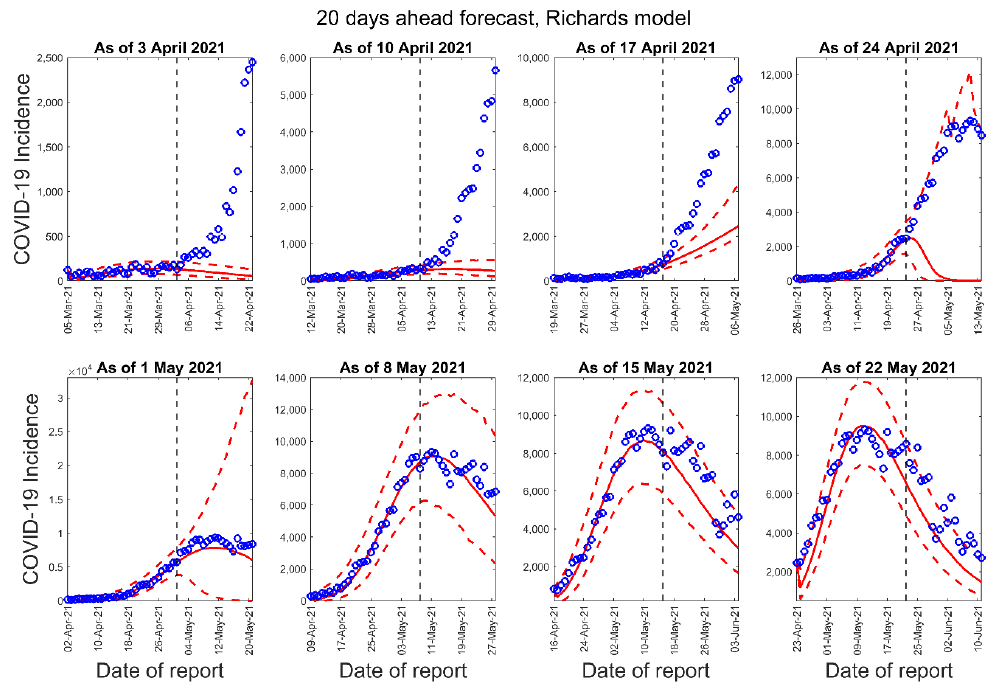
Figure 7. Twenty-days ahead forecasts of the COVID-19 epidemic curves in Nepal by calibrating the Richards model for eight different periods. Blue circles correspond to the data points; the solid red line indicates the best model fit, and the red dashed lines represent the 95% prediction interval. The vertical black dashed line represents the time of the start of the forecast period.